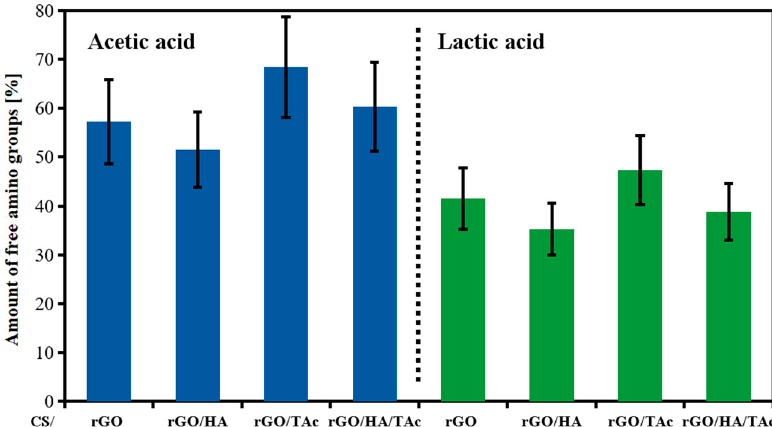
Figure 3. Amount of free amino groups in CS composites measured by ninhydrin assay (CS—chitosan, rGO—reduced graphene oxide, HA—hydroxyapatite, TAc—tannic acid).